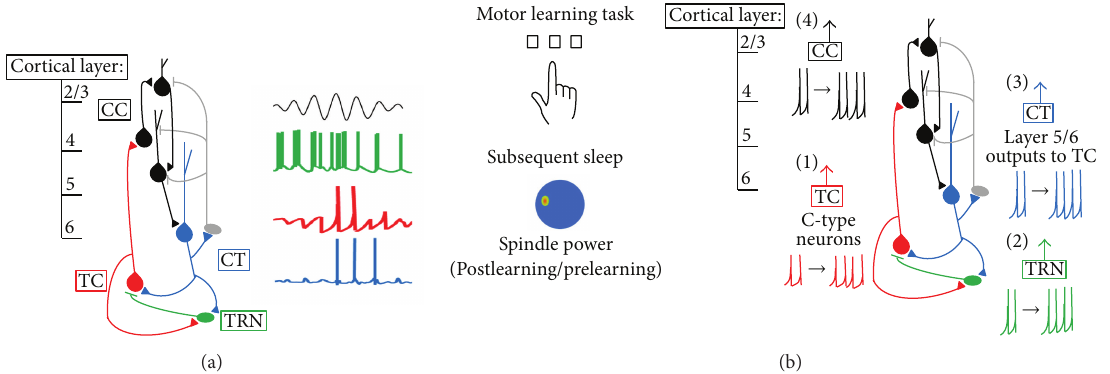
Figure 1: Spindles generation within the CT-TRN-TC circuit. (a) Sleep spindles are generated through reciprocal interactions of the TRN ( green )andTC( red )neurons.SpindlescanbeinitiatedbyexcitatoryinputfromCT( blue )neurons,whichalsosynchronizespindleoscillations across the thalamocortical network. Representative neural firing patterns ( right ) show the order and organization of firing for CT, TRN, and TC neurons, respectively (adapted from [9]). As TC neurons fire, they provide input to both cortical and TRN neurons, and these populations phase-locktheirfiring.Ascortical,TRN,andTCneuronsdesynchronizetheirfiring,thespindleoscillationwanes.(b)TheCT-TRN-TCcircuit may also generate local spindles following waking experience. For example, training on a motor task leads to increased sleep spindles over the contralateral motor cortex during subsequent sleep ( left ; adapted from [10]). There are several possible mechanisms by which changes to CT-TRN-TC circuitry during waking could cause subsequent local spindle increases ( right ). TC projections may show changes to dynamics (e.g., firing rate or bursting) based on prior waking experience (1). Experience may alter TRN excitability or bursting during subsequent sleep (2). CT feedback may be altered by experience to increase synchronization or amplification of spindles (3). Finally, intracortical plasticity could amplify spindles locally